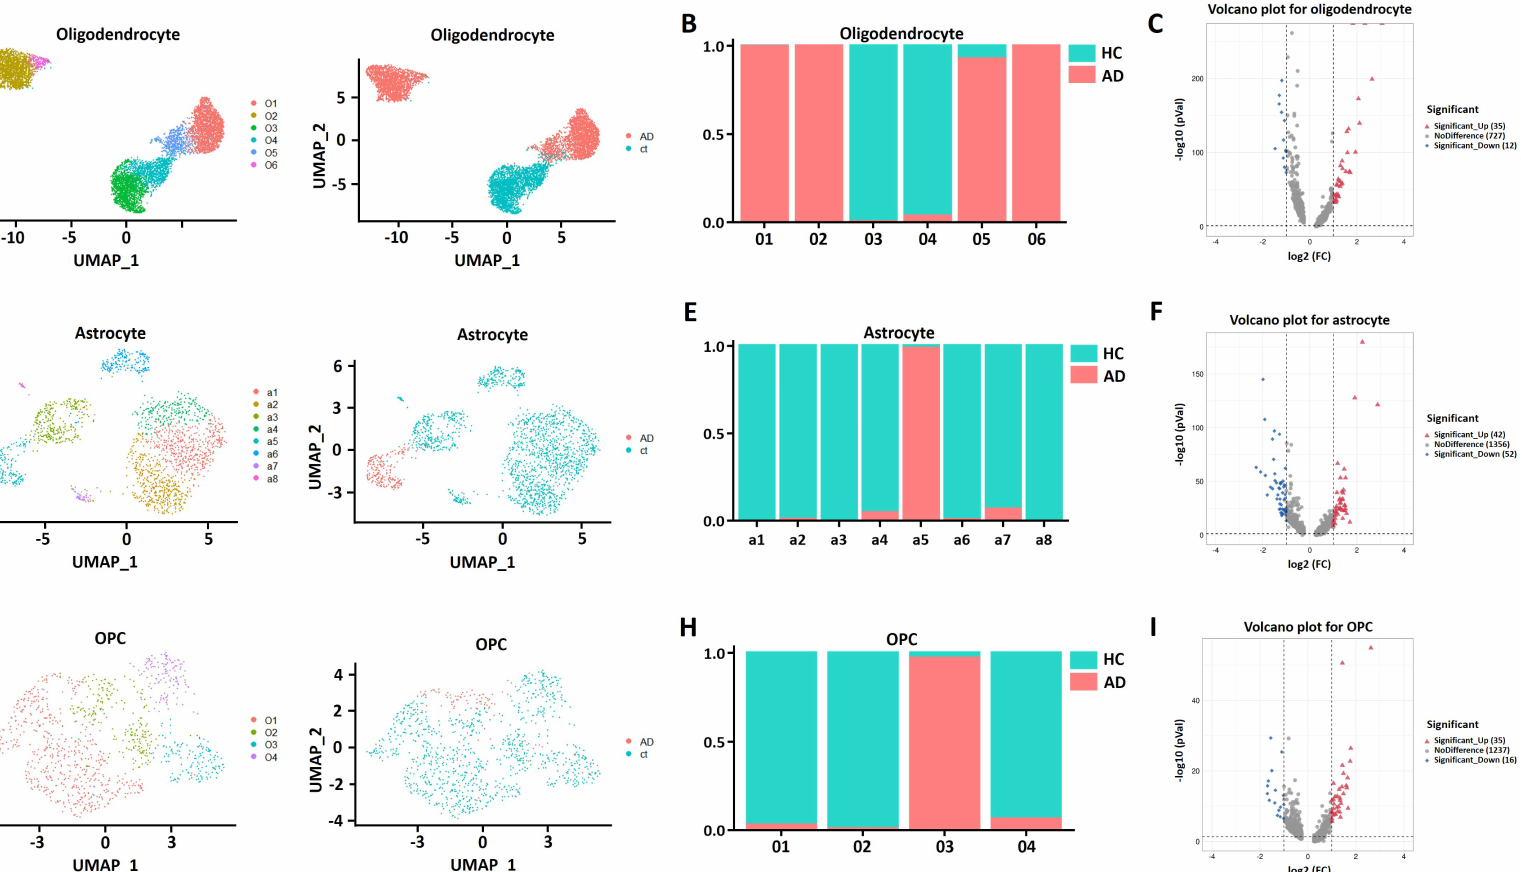
Figure 4. Overview of cell subsets. ( A ) UMAP visualization of subclustered oligodendrocytes colored by major cell lineage ( left ) and sample type (right). ( B ) Fraction of subclustered oligodendrocytes. ( C ) Volcano plot of DEGs in oligodendrocytes. ( D ) UMAP visualization of subclustered astrocytes colored by major cell lineage ( left ) and sample type ( right ). ( E ) Fraction of sub-clustered astrocytes. ( F ) Volcano plot of DEGs in astrocytes. ( G ) UMAP visualization of subclustered OPCs colored the major cell lineage ( left ) and sample type (right). ( H ) Fraction of subclustered OPCs. ( I ) Volcano plot of DEGs in OPCs. FC: fold change. pVal: p